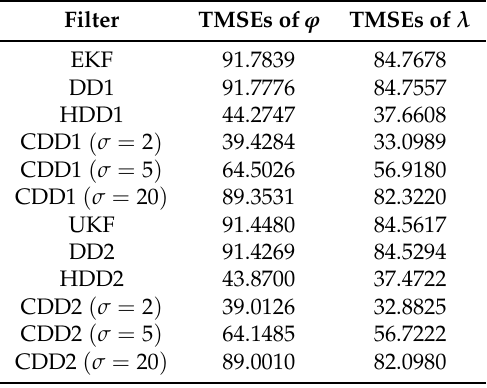
Table 4. TMSEs of position in non-Gaussian